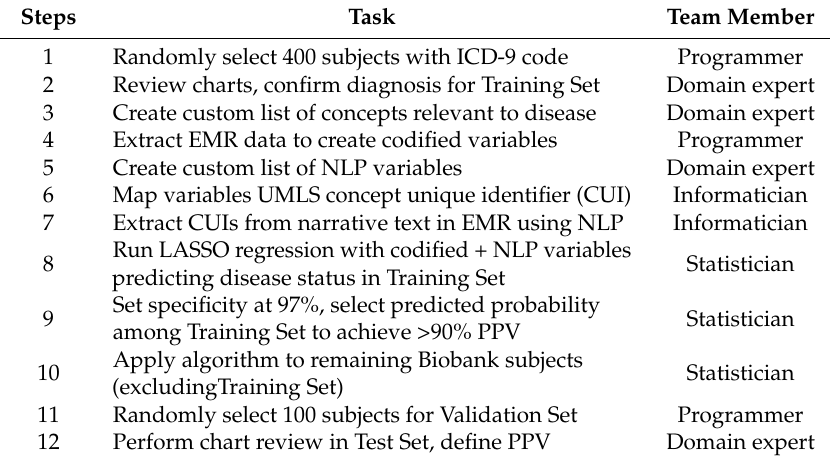
Table 1. i2b2 method for defining disease phenotype